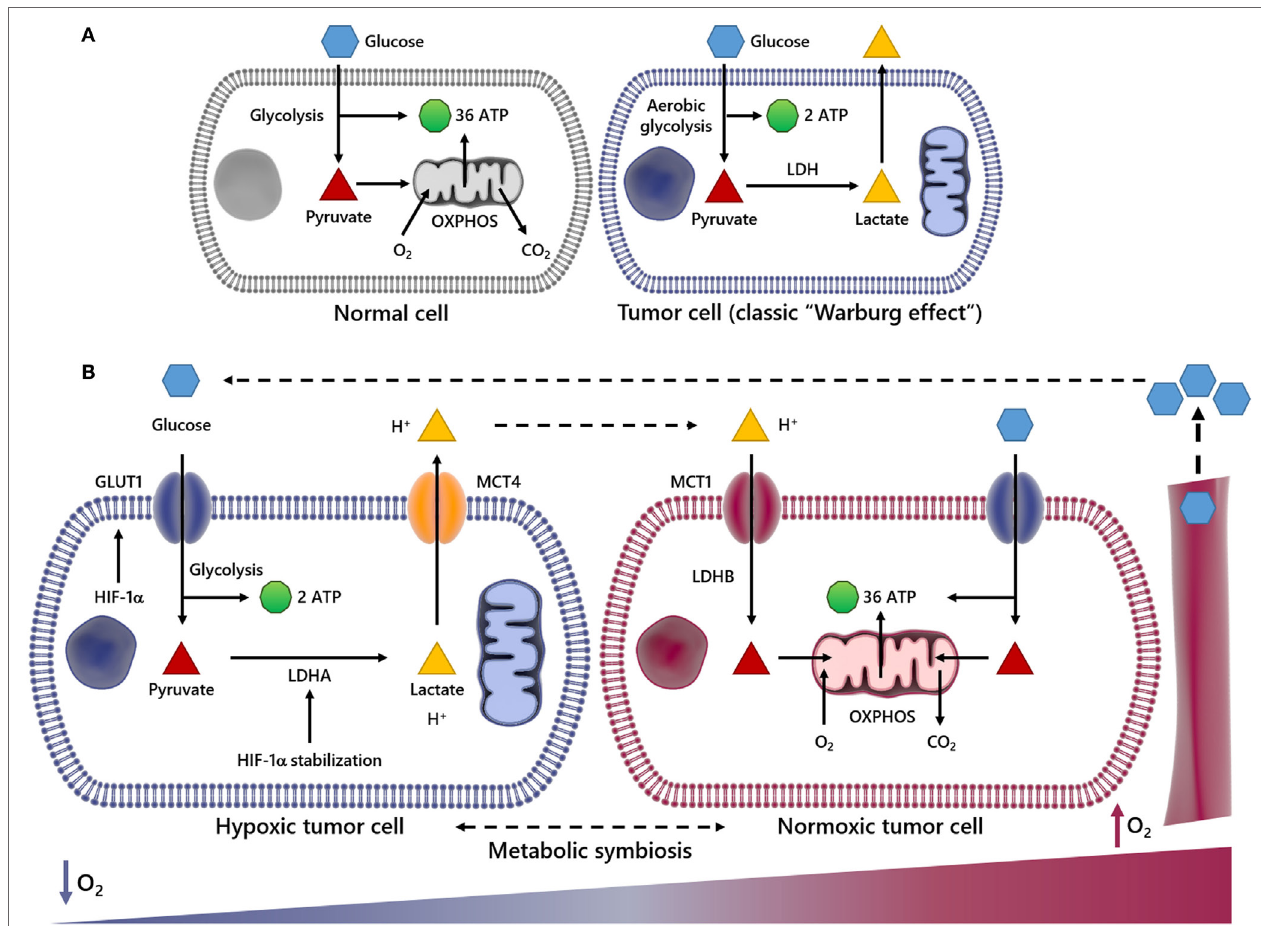
FiGURe 1 | Scheme summarizing metabolic differences between normal and cancer cells and metabolic symbiosis. In normal cells, glucose (Glc) is initially metabolized to pyruvate and further to carbon dioxide (CO 2 ) through tricarboxylic acid cycle and oxidative phosphorylation (OXPHOS) processes in the mitochondria, generating 36 ATP molecules per Glc molecule consumed (A) . In this process, O 2 is indispensable, since it is used as the final electron acceptor (A) . However, in cancer cells undergoing aerobic glycolysis (Warburg effect), Glc is broken down into pyruvate and finally converted into lactate, deviating Glc metabolites from energy production to anabolic process. This event generates two ATP molecules per Glc molecule. The panel (B) illustrates an event named metabolic symbiosis. It has been well documented that when cancer cells are near or distant of blood vessels, they are well or poorly oxygenated, respectively. It is also known that when cancer cells are subject to low oxygen tension ( ↓ O 2 ) hypoxia-inducible factor-1 α (HIF-1 α ) is stabilized, increasing the transcriptional activation of genes encoding glucose transporters (GLUTs), lactate dehydrogenase A (LDHA), as well as the uptake of Glc and secretion of lactate and protons out of cytoplasm through the monocarboxylated transporter 4 (MCT4). However, when transformed cells are close to blood vessels and the availability of O 2 is enough, lactate is taken by monocarboxylated transporter 1 (MCT1) and utilized as energy source after conversion into pyruvate by lactate dehydrogenase B (LDHB). In this way, lactate may not be pointed out as a waste metabolite, since it is reused by different cell subpopulations in a